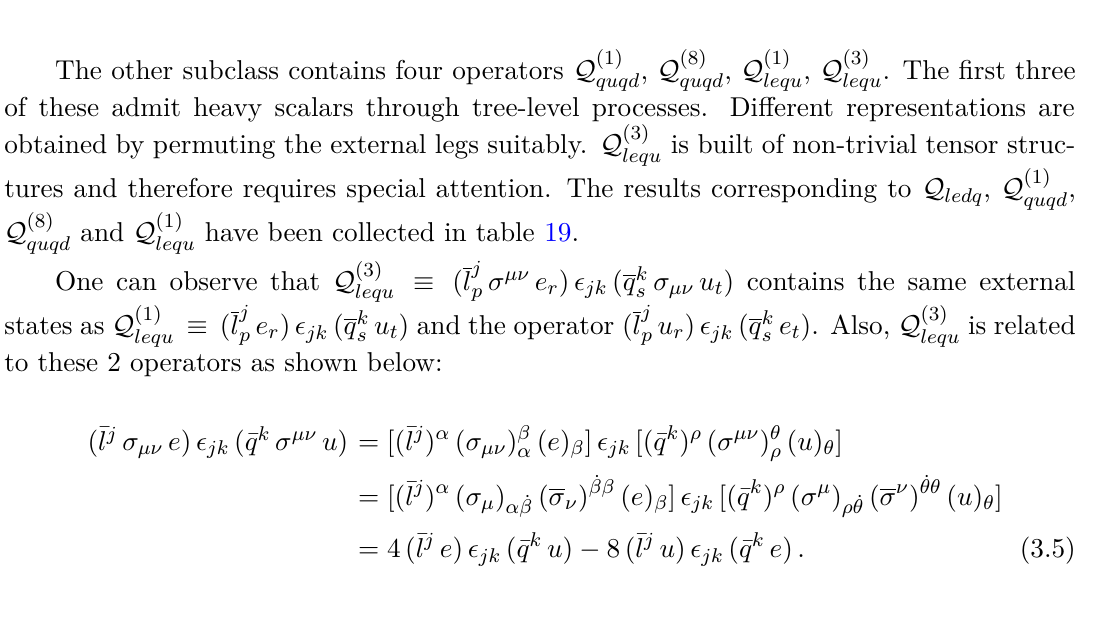
Table 16 . Heavy field representations that are obtained by unfolding the ψ 4 operators, composed of both left and the right chiral SM fermions, into non-trivial one-loop-level diagrams and the corresponding vertices. Each of the processes highlighted here are flavour conserving. In each sub-table, operators with different fermions as external legs but leading to identical heavy field representations through similar diagrams have been grouped together. The headers schematically describe the covariant forms of the